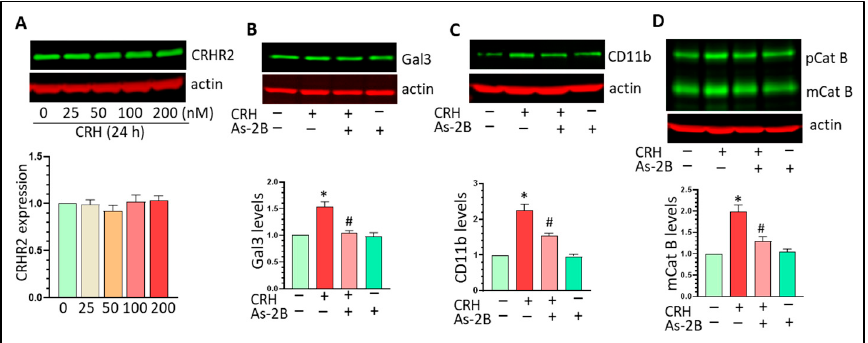
Figure 6. CRHR2 blockage mitigates CRH-mediated effects on Mg. ( A ): CRH has no effects on CRHR2 levels in BV2 cells; ( B ): As-2B mitigates CRH-mediated upregulation ofGal3 (* p < 0.05 vs. control, # p < 0.05, vs. CRH treatment); ( C ): As-2B mitigates CRH-mediated upregulation effects on CD11n (* p < 0.05 vs. control, # p < 0.05, vs. CRH treatment); ( D ): As-2B mitigates CRH-mediated upregulation effects on mCat B (* p < 0.05 vs. control, # p < 0.05, vs. CRH treatment). All experiments were independently repeated at least three times for statistical analysis.